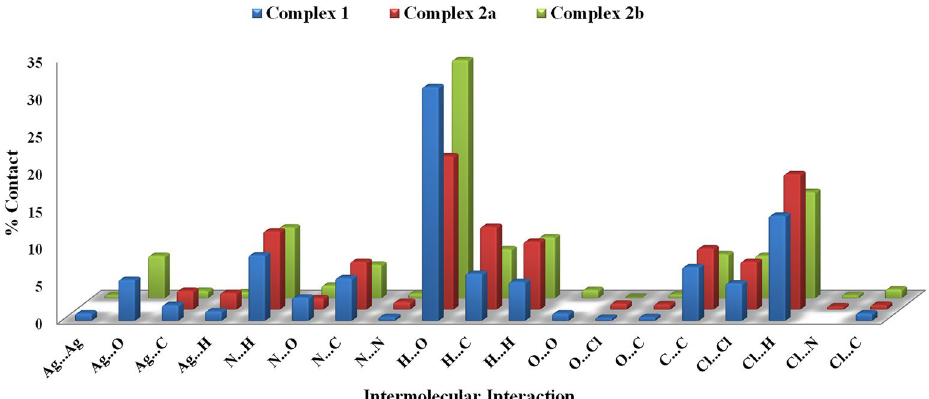
Figure 9. The percentage contributions of all intermolecular interactions in the crystal structure of the investigated Ag(I)